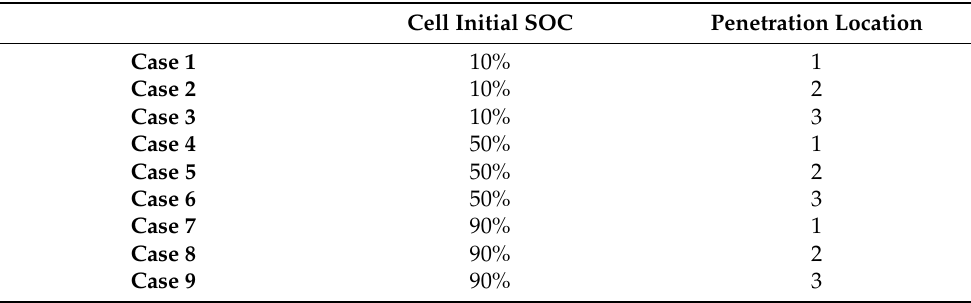
Figure 1. Penetration test setup (left), closer look of penetrating cone (middle), and penetration locations and thermocouple locations with unit in mm (right). Table 2. Testing cases of penetration